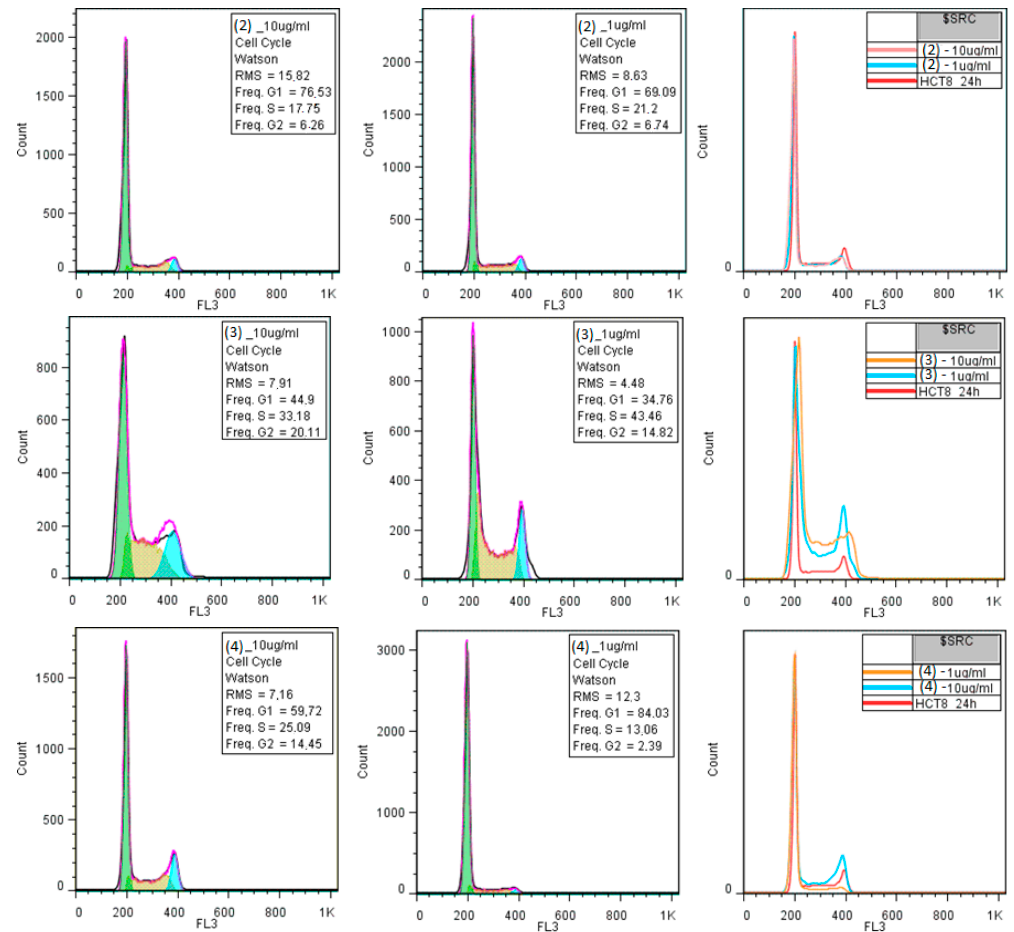
Figure 9. The effects of 10 μ g/mL (left histograms) or 1 μ g/mL (middle histograms) compounds on the HCT8 cell cycle progression. In the right is represented the overlaid histograms of treated and untreated HCT8 cells.